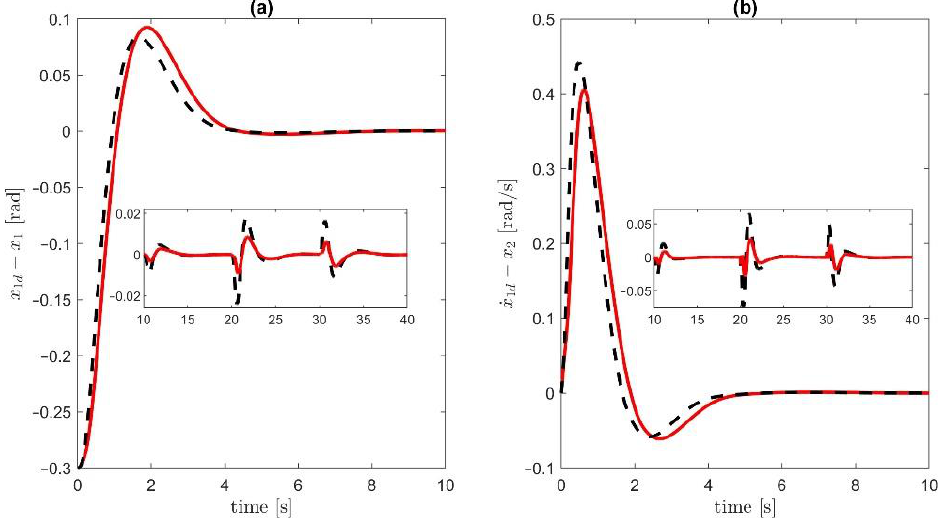
. x 1 d − x 2 . Dashed black line— k 1 = k 2 = k 3 = = 𝑘 = 𝑘 = 𝑘 = 15 . 1 2 3 4 = 𝑘 = 𝑘 = 𝑘 = 15 . 1 2 3 4